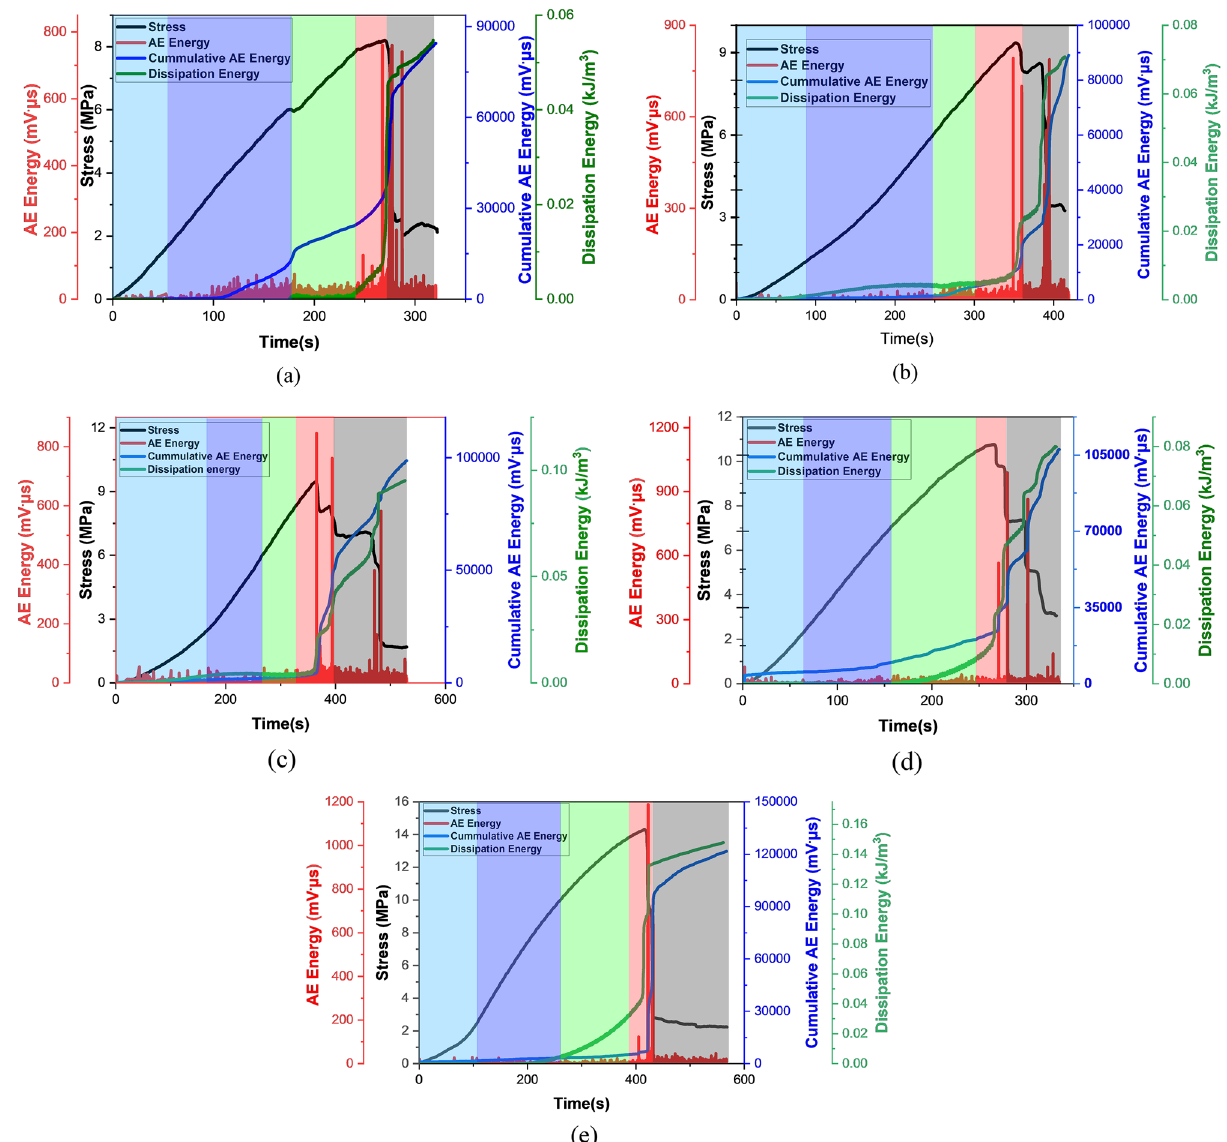
Figure 8. Illustration of the relationship between acoustic emission energy, cumulative and dissipation energy over time of group 1 samples, ( a – e )